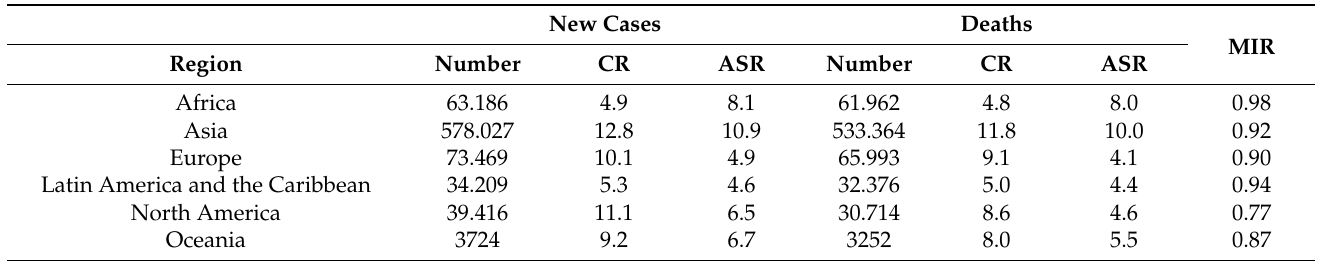
Table 1. Summary of the number, crude rate (CR), age-standardized rate (ASR) and mortality-to- incidence ratio (MIR) of liver cancer according to the